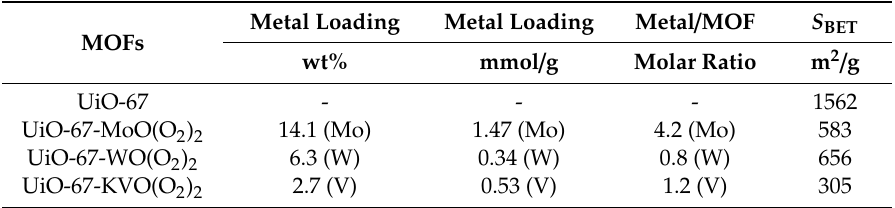
Figure 3. SEM of UiO-67-KVO(O 2 ) 2 .